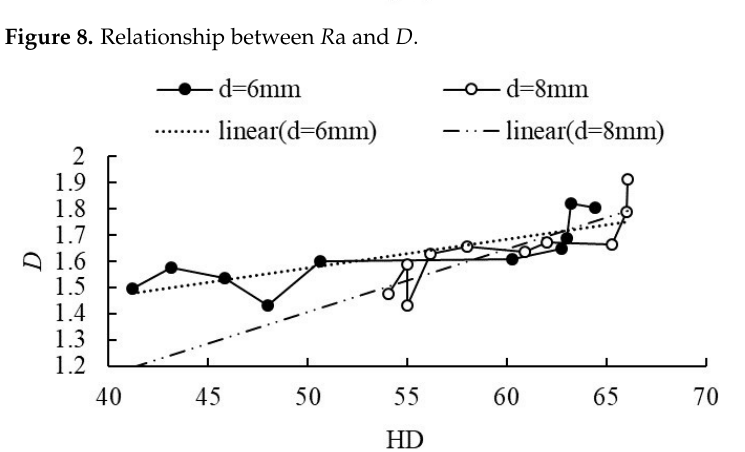
Figure 9. Relationship between HD and D